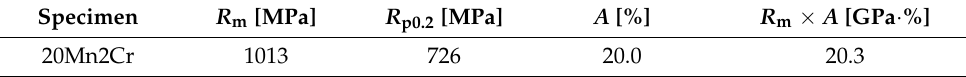
Figure 3. Engineering stress–strain curve of cold-rolled sheets after continuous annealing. Table 2. Tensile properties of cold-rolled sheets after continuous annealing.